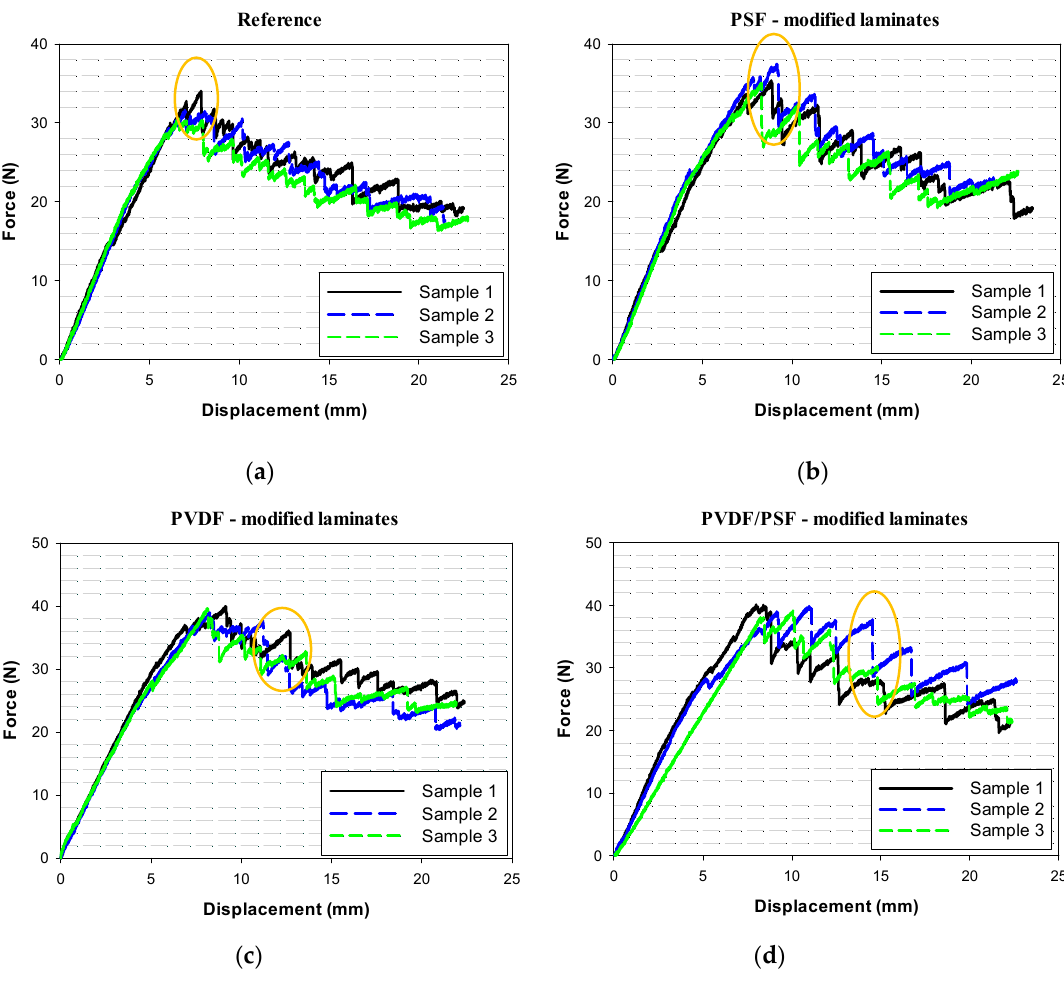
Figure 4. End ‐ notched flexure ( ENF) sample under Mode ‐ II test. 3. Results 3.1. Test Results Figure 5 shows the force ‐ displacement curves for the reference and modified samples under DCB loadings, and Table 3 presents the results. As seen, the PSF and PVDF did not affect the slope of the linear loading phase before crack propagation. An interesting phenomenon is observed while the crack propagates. In the reference laminate, a high number of short rises and falls of the force is registered, unlike the modified laminates, especially the PSF ‐ and PVDF/PSF ‐ modified ones, where a lower number of variations is registered (see the orange ovals in the figures). In nanomodified samples, the force rises after a drop up to about 6N, which is 15% of the maximum load. The maximum load (Fmax) was 32.7 N for the reference laminate, and it increased 11% and 21%